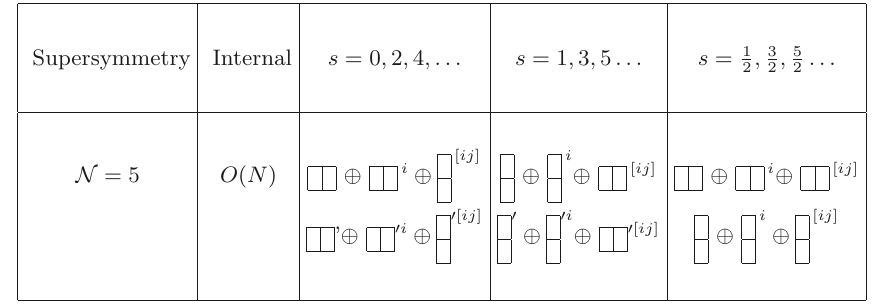
= 5 ABJ theory in the limit (1.2). N